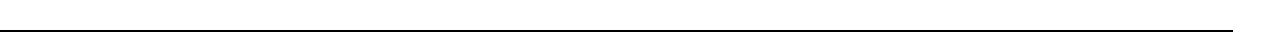
Fig. 2 Loss of DOT1 rescues the cryptic transcription of set2 Δ cells in a methylation-independent manner. a mRNA-seq data in wild-type (gray), set2 Δ (black), and dot1 Δ set2 Δ (magenta) mutants for the cryptic loci, SPB4 , STE11 , and PCA1 . The plus and minus values of the y -axis indicate level of mRNA read counts and the sense and antisense strands, respectively (left to right, +; right to left, − ). The read count data were obtained from biological duplicates. The orange boxes indicate an enlarged view for peak of cryptic transcription in each loci. The values of zoom-up box represents y -axis values. b A boxplot of the log 2 fold change values of set2 Δ (black), dot1 Δ set2 Δ (magenta), and Dot1(G401R) set2 Δ (blue) mutants versus the levels in wild-type cells for genes that showed increased mRNA expression in set2 Δ cells ( n = 533). The Cuffdiff analysis program was used. The genes that passed the correction test in Cuffdiff were collected, and their fold change values versus wild-type levels were calculated. Data were obtained from biological duplicates. *** P -value < 0.001. c A boxplot of the log 2 fold change values for the set2 Δ (black) and H3K79Rset2 Δ (turquoise) histone residue modi fi ed mutants versus their wild-type strain ( wzy42 ). Data were obtained from biological duplicates; n.s., p -value > 0.05 (Wilcoxon and Mann – Whitney tests). d mRNA-seq data were obtained for Dot1 methylation activity-associated mutants using the cryptic gene, PCA1 . set2 Δ cells (color black) were used as a positive control. Dot1(G401R)set2 Δ was based on the w303a wild-type (color blue, upper windows), while H3K79Rset2 Δ was based on the wzy42 wild-type (color turquoise, lower windows). The values of the y -axis indicate level of mRNA read counts. e RT-qPCR analysis of cryptic transcription at the cryptic loci, FLO8 (upper) and PCA1 (bottom) from three biological repeats. The expression level of the 3 ′ -end of each RNA was normalized by that of the corresponding 5 ′ -end. The mutant values were normalized by that of the wild-type. The error bars represent the s.d. for the biological replicates. *** P -value < 0.001; ** p -value < 0.01; * p -value < 0.05; n.s., p -value > 0.05 generated by analysis of variance (ANOVA) using the R statistic program. The levels of mRNA were quanti fi ed by quantitative PCR